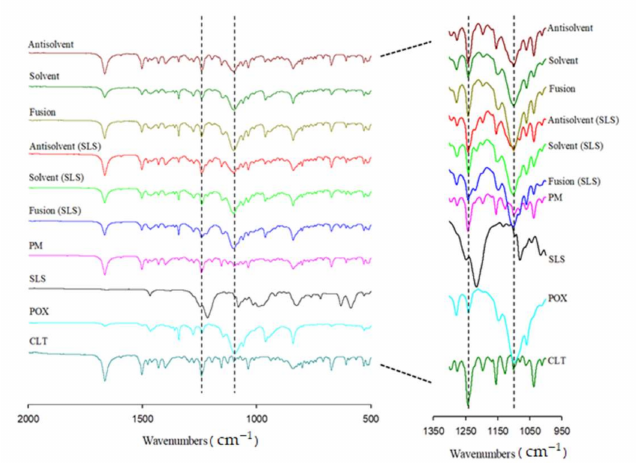
Figure 3. Fourier-transform infrared spectra of pure cilostazol (CLT), poloxamer, sodium lauryl sulfate (SLS), physical mixture (PM), and solid dispersions